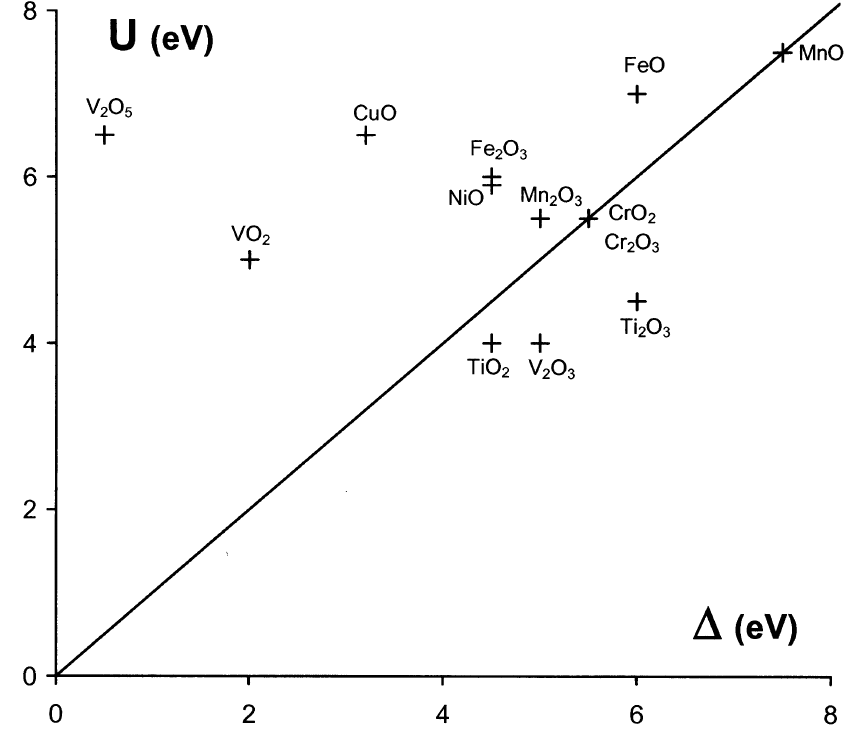
FIGURE 7 Zaanen-Sawatzky D - U dd diagram for various 3 d -transition-metal oxides giving the nature of the insulating state as a function of the cation-cation charge fluctuation energy U dd and the energy D for anion-cation charge